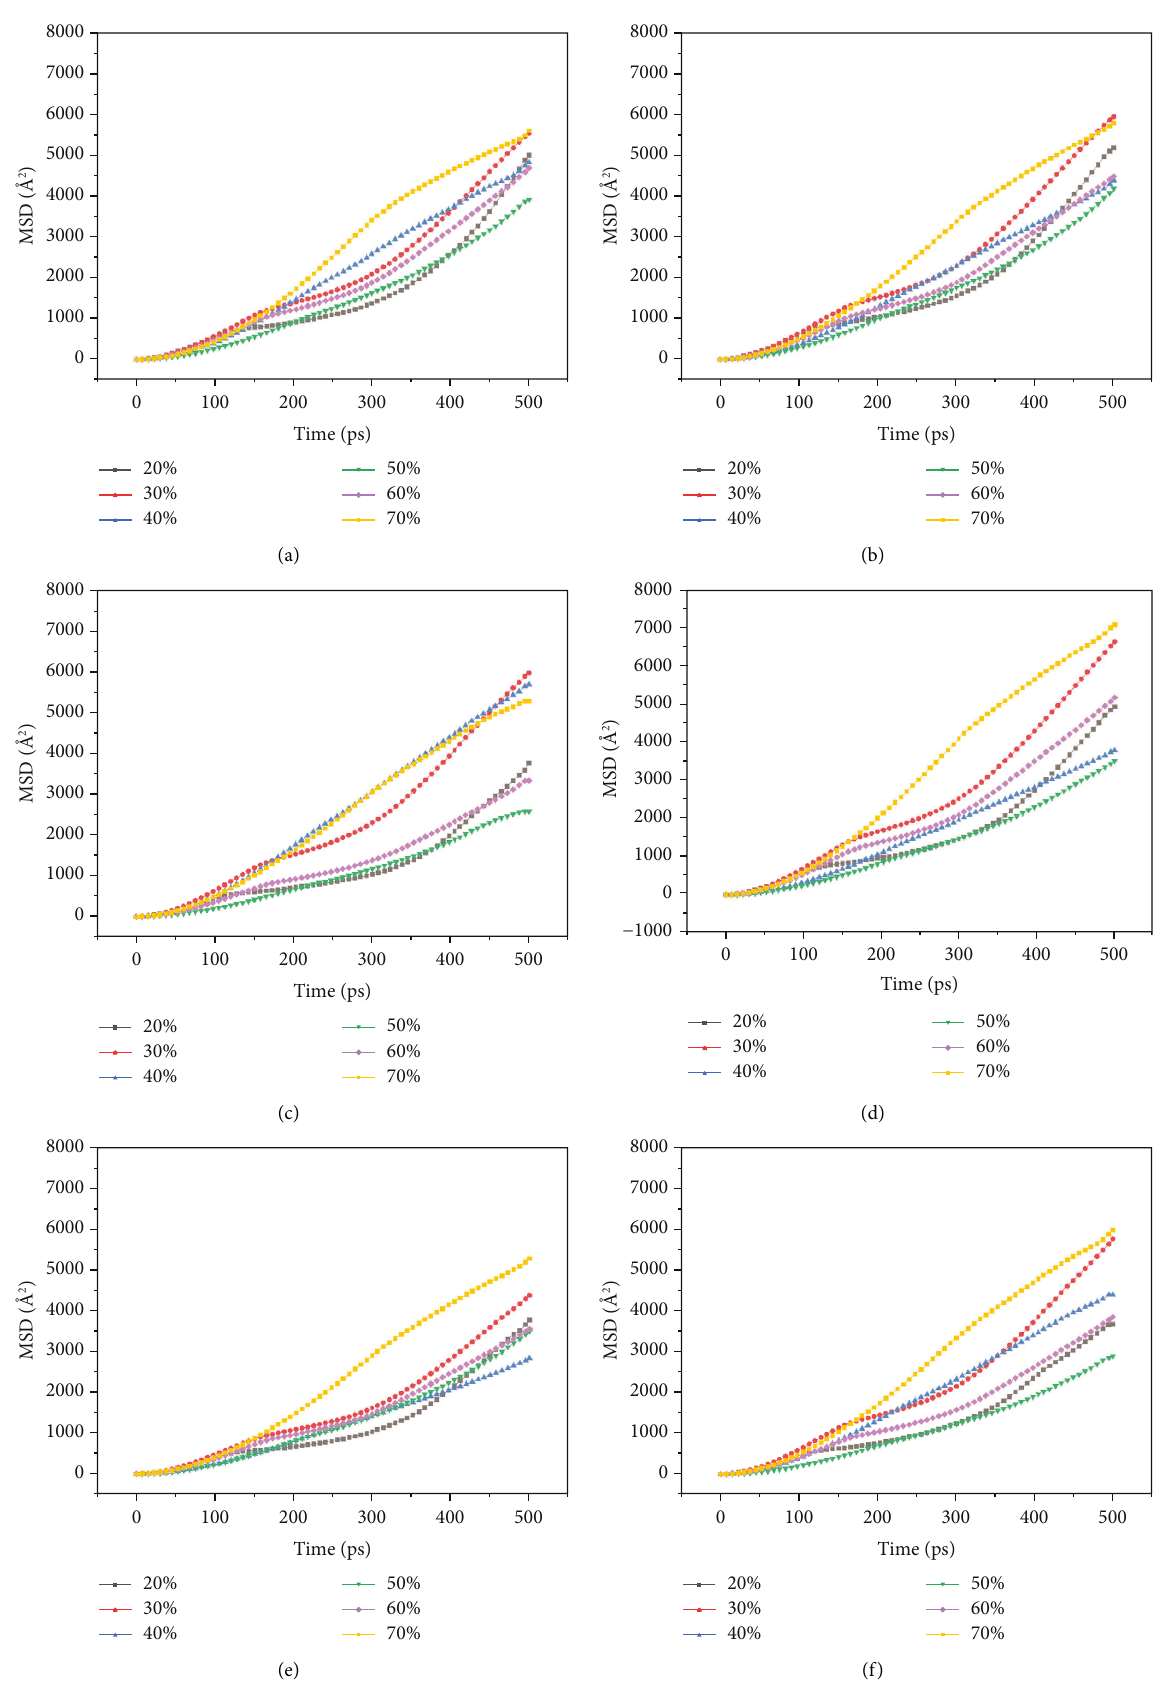
Figure 7: MSD curves of different components in CRMAs: (a) asphaltene; (b) aromatic; (c) saturate; (d) resin; (e) rubber; and (f) waste